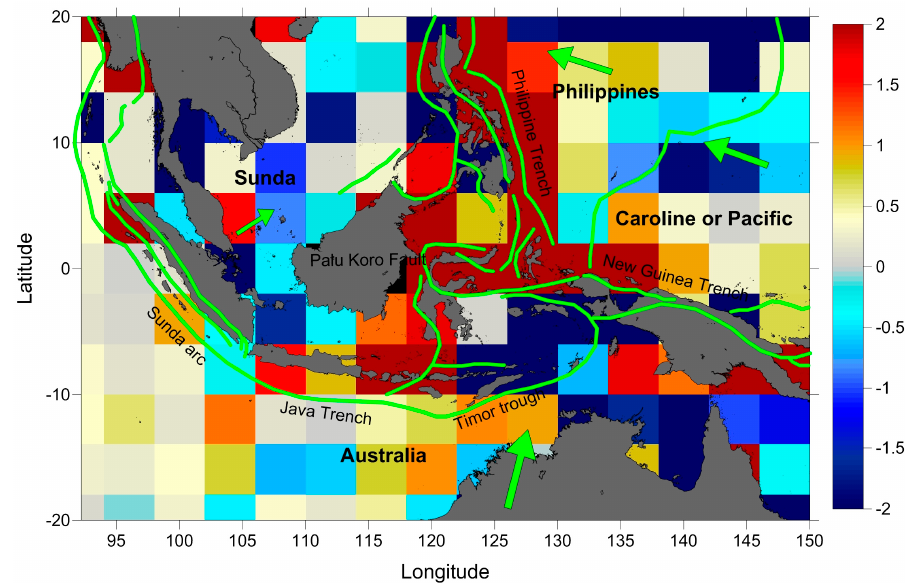
Figure 25. Overlaying along-track SLA variance differences (cm 2 ), between DTU13 and CNESCLS2011 MSS models for Jason-2 and Structure map of the Sunda-Australia-Philippine-Pacific plates junction area. The green lines are the plate boundaries and the arrows depict the far-field velocity of the plates with respect to Eurasia [69].